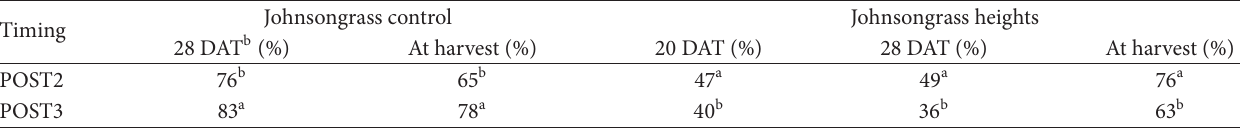
Table 3: Glyphosate-resistant rhizomatous johnsongrass control 28 d after treatment (DAT) and at harvest and heights as a percent of the nontreated 20 and 28 DAT and at harvest as influenced by POST2 or POST3 sequential glufosinate application timing a . Johnsongrass control Johnsongrass heights Timing 28 DAT b (%) At harvest (%) 20 DAT (%) 28 DAT (%) At harvest (%) POST2 76 b 65 b 47 a POST3 83 a 78 a